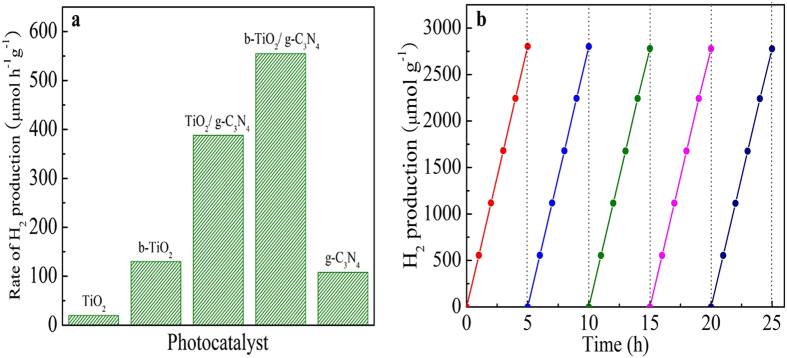
The photocatalytic H2 evolution of different samples (a) and the recyclability tests of b-TiO2/g-C3N4 during the photocatalytic H2 evolution under AM 1.5 (b).